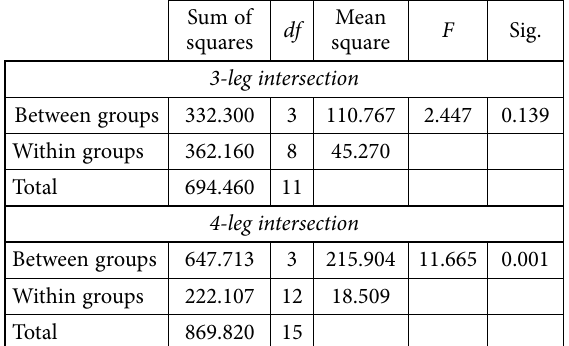
Table 6. ANOVA per part of the day